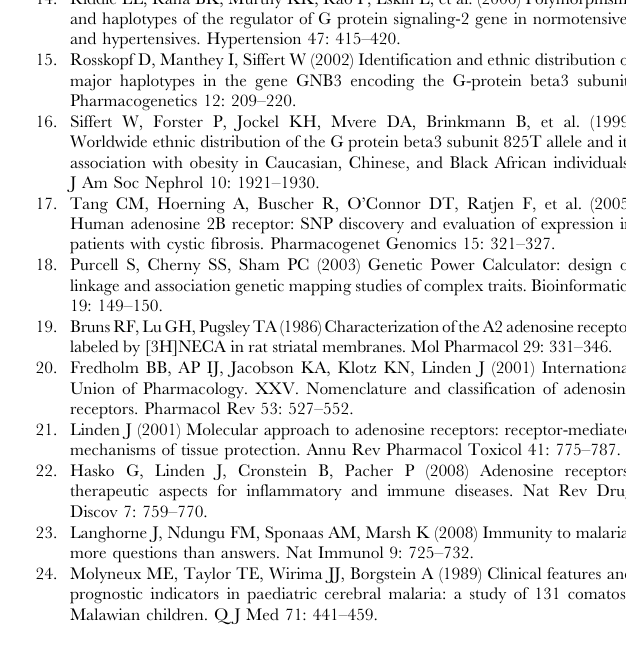
Table S2 Severe malaria subphenotype frequencies. CM: Cerebral malaria. SA: Severe anaemia.